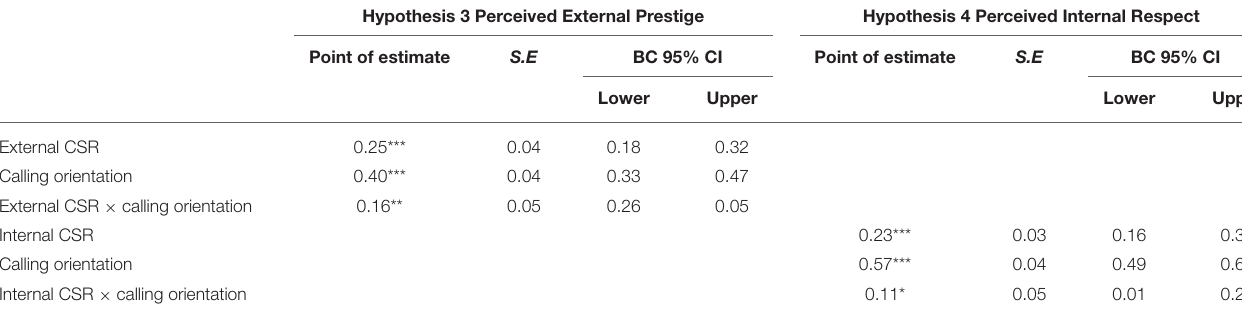
TABLE 4 | Moderation hypotheses results.